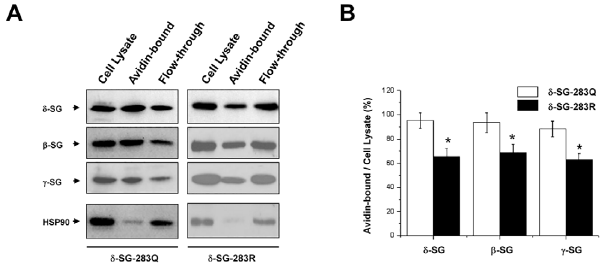
Fig 6. Effect of δ -SG-283R on Localization of β / δ / γ -SG to the Plasma Membrane Surface. Fig 6 A compares cell surface biotinylation assay results between δ -SG-283Q and δ -SG-283R. In HEK293T cells, full-length δ -SG-283Q or δ -SG-283R was separately co-expressed with full-length β -SG and γ -SG. The amount of transfected sarcoglycans targeted to the cell surface was determined by labeling cells with membrane-impermeable NHS-LC-biotin. Biotinylated proteins were isolated with avidin and identified by WB. The specificity of cell surface biotinylation was demonstrated by the absence of cytoplasmic HSP70 in the avidin-bound fraction. In each lane, 10 μ g protein was loaded. Fig 6 B shows a statistic summary from 5 independent assays. * : p < 0.05 vs δ